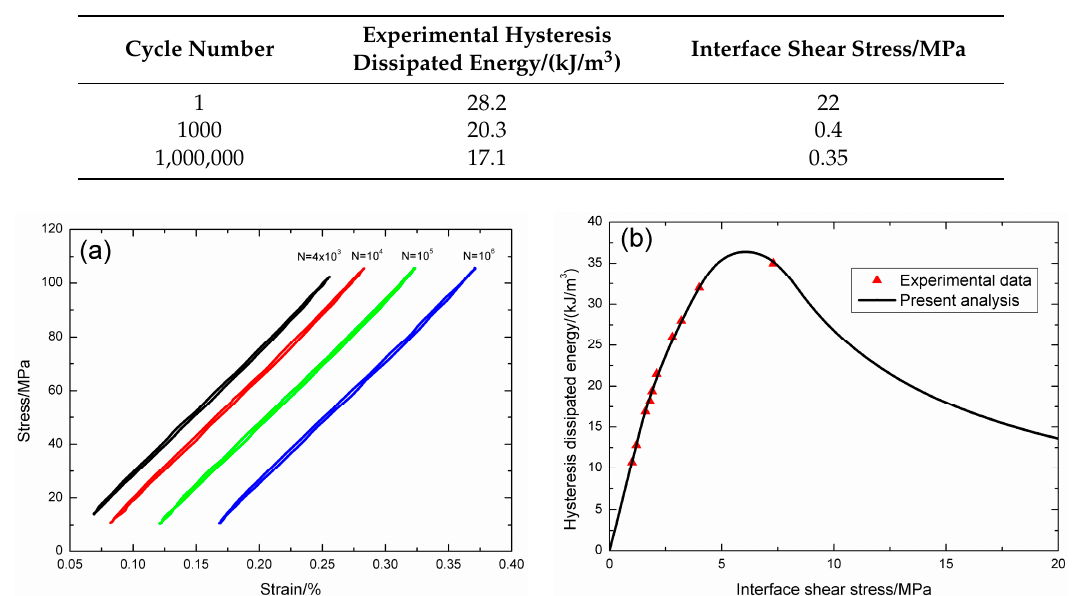
Table 2. The interface shear stress of 2D woven C/SiC composite corresponding to different applied cycles under fatigue peak stress of σ max = 335 MPa at room temperature.